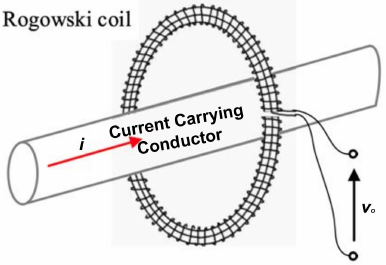
Figure 1. A Rogowski Coil Fitted around a Current-Carrying